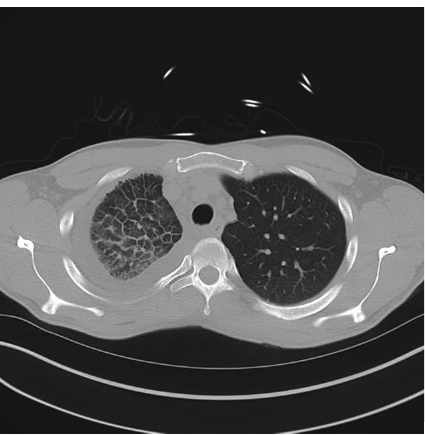
Figure 1: Axial plane showing right lung volume loss, secondary lobules, and thickened septa.